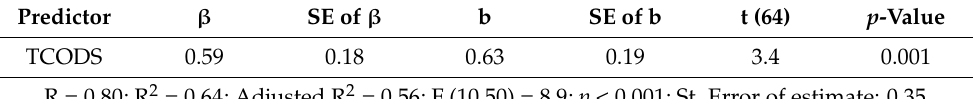
Table 3. Results of the multiple regression analysis for boys for TRAG as a criterion. Predictor β SE of β b SE of b t (64) p -Value TCODS 0.59 0.18 0.63 0.19 3.4